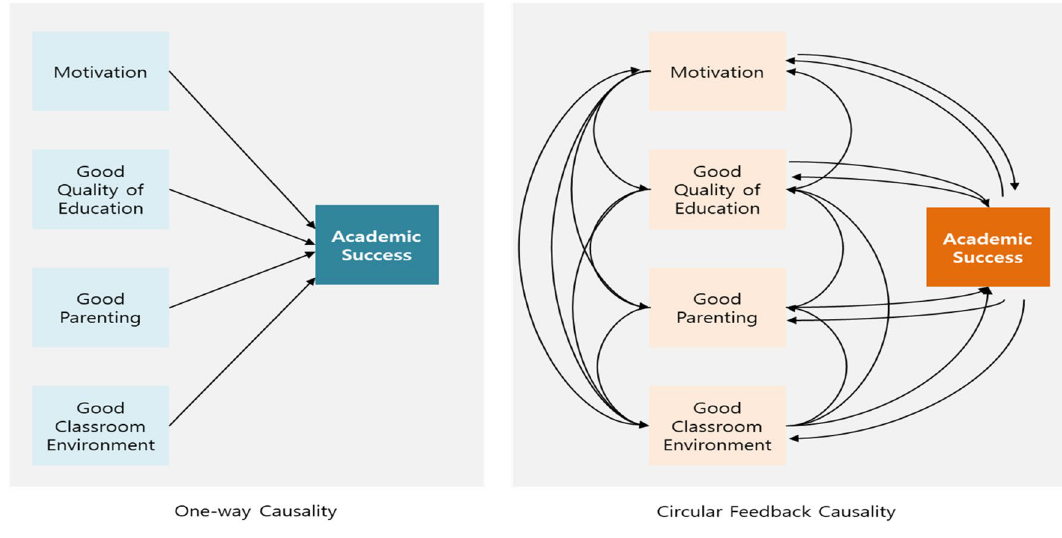
Figure 1. One way causality vs. Circular feedback causality 22